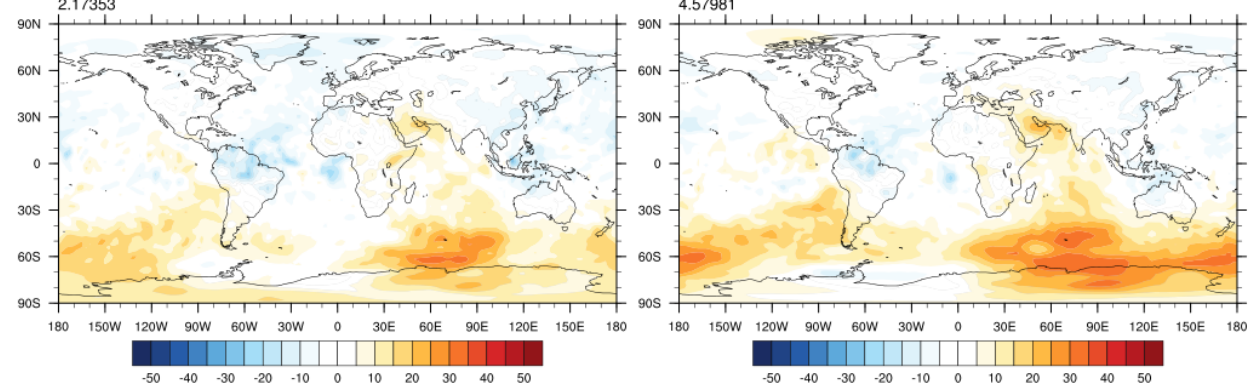
Figure 9. Relative uncertainty reduction of EXP_RO from CTRL_SONDE, computed by Eq. (9) for the variable U (left) and T (right) at the 100hPa level for a 2-week analysis period.